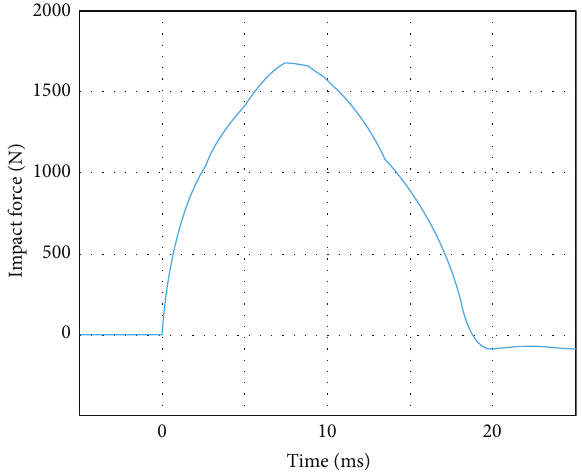
Figure 2: Waveform of impact force of rubber ball